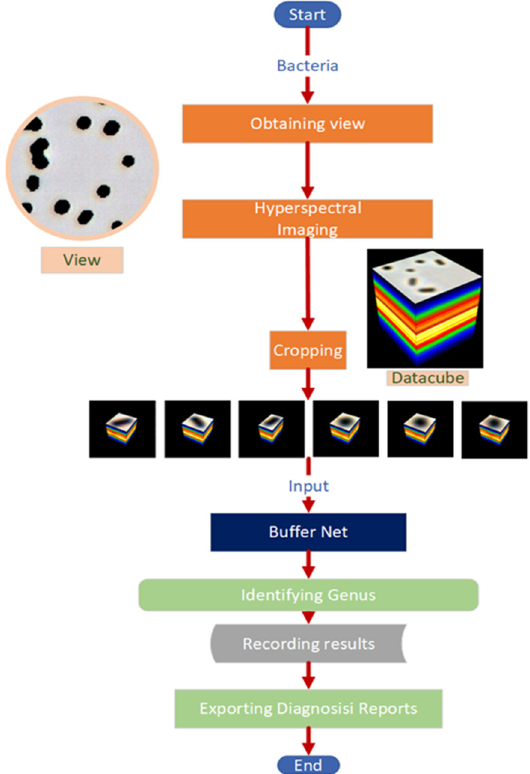
Figure 1. Workflow diagram of the AI-assisted system. The field of view of the bacteria made into slides is acquired under a microscope with 100 × magnification and then imaged. The bacteria in the datacube obtained by imaging are cropped out and fed into the Buffer Net. The identification results are recorded and exported to help physicians make a diagnosis. Table 1. The number of